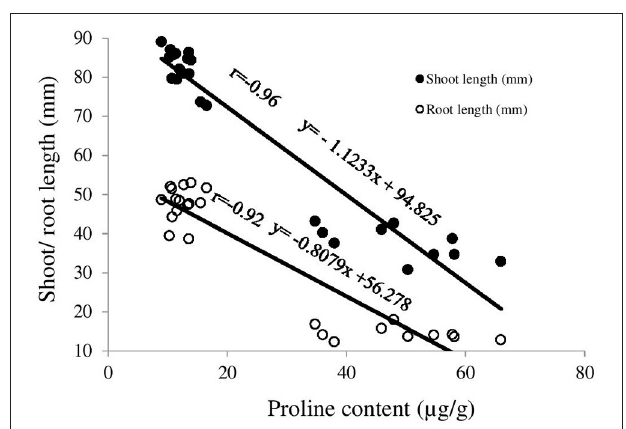
FIGURE 2 | Correlation between proline content and shoot/root length of ryegrass (pre-emergent). The x-axis denotes proline content of leaf ( µ g/g) and y-axis denotes shoot and root length (mm) of ryegrass. The trend line with filled circle marker represents correlation between proline content and shoot length while trend line with non-filled circle marker represents correlation between proline content and root